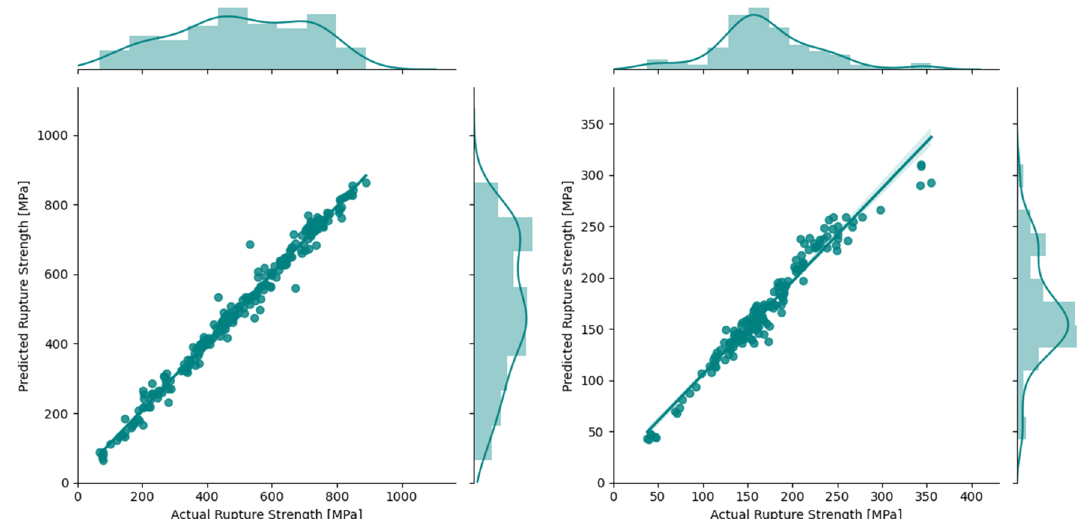
Figure 4. Parity plot for the testing data for GBDT regression for the 9–12% Cr FMA (left) and austenitic stainless steel